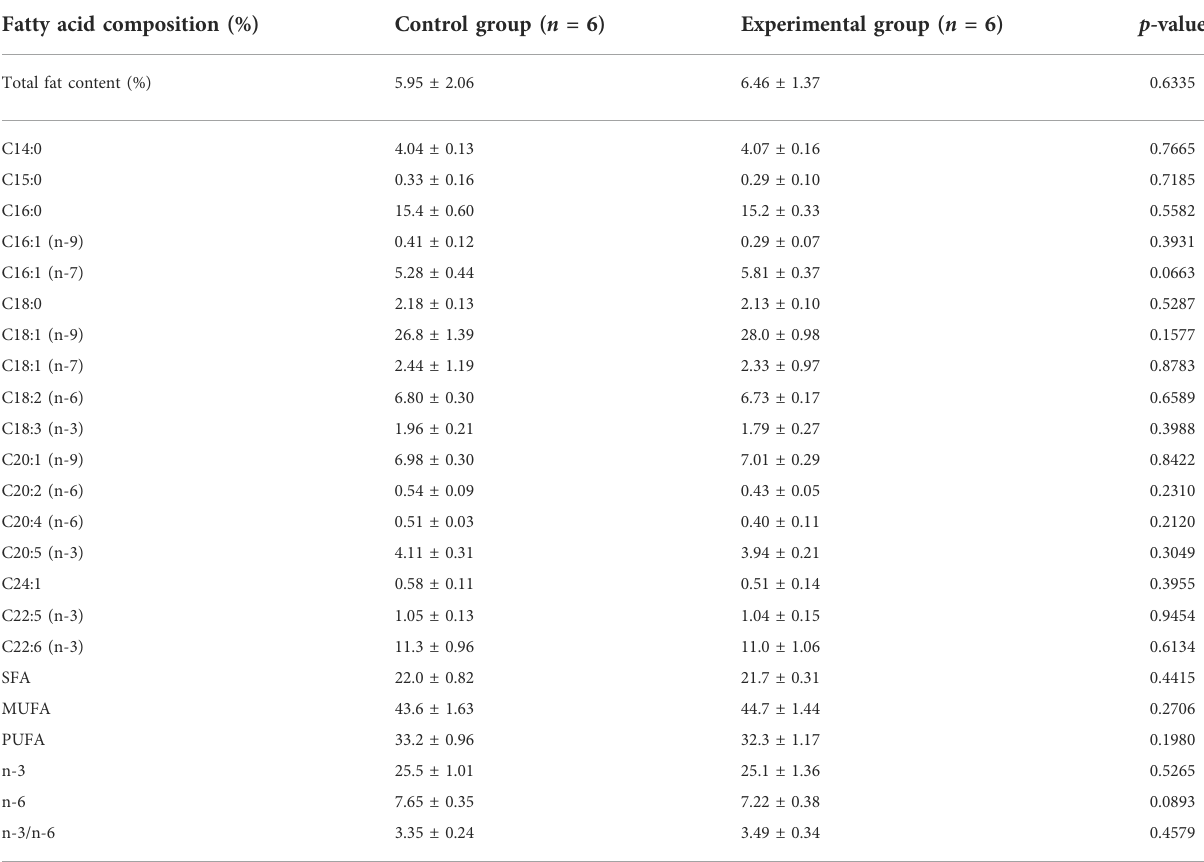
TABLE 5 Total fat content (%) and fatty acid pro fi le in the fi llet (dark and light muscle; % of total identi fi ed FA) from Arctic char fed with control feed and experimental yeast feed. Data are presented as mean ± standard deviation, ( n = 12 in total, 3 technical replicates). Statistical signi fi cance was set at p -value <